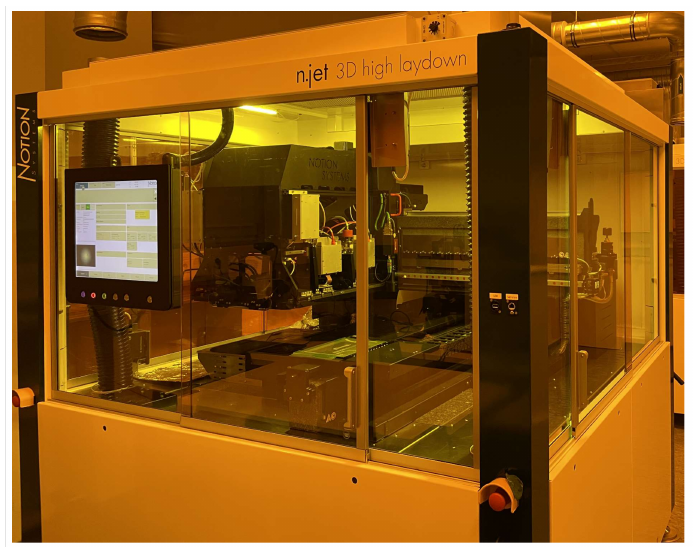
Figure 12. Notion Systems high laydown printer.